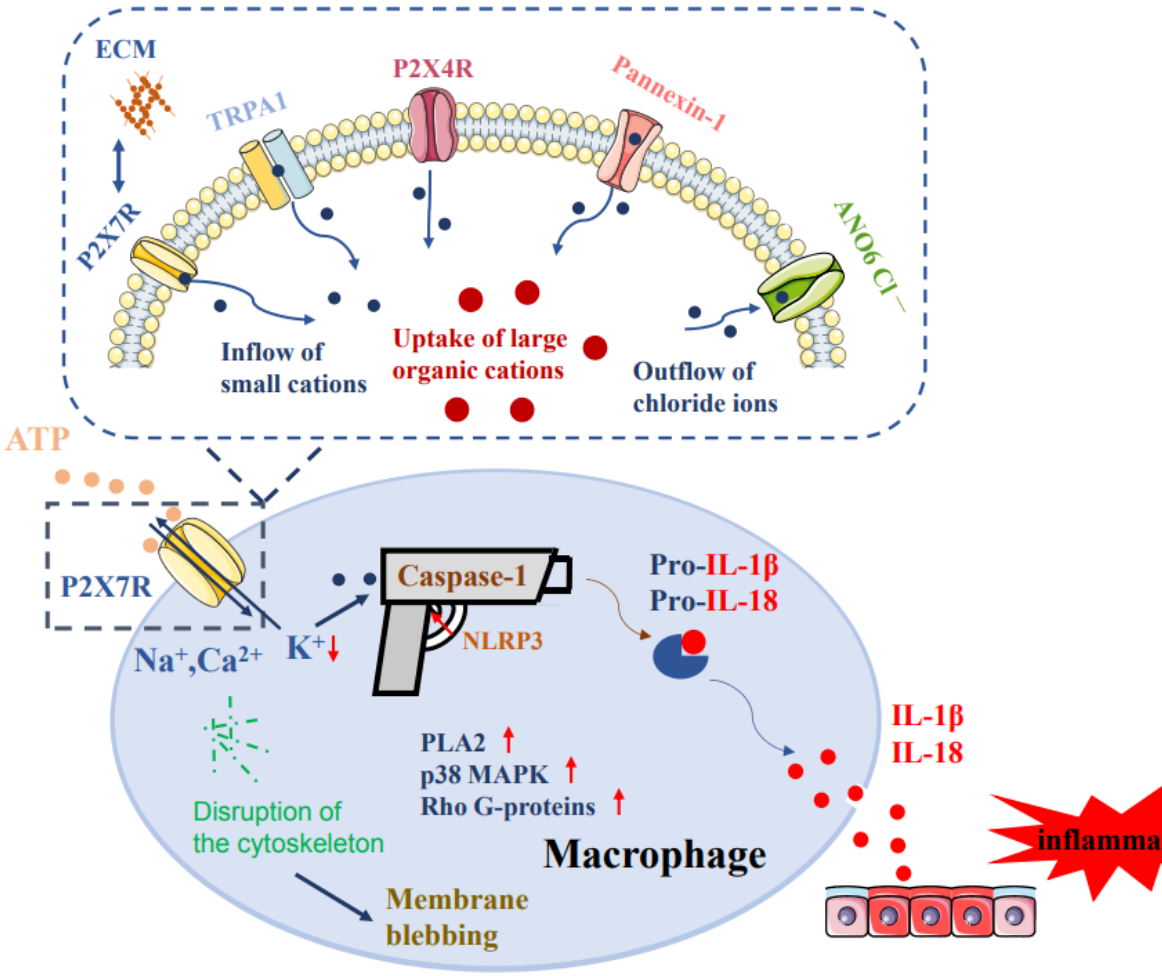
Figure 3. Role of P2X7Rs in macrophages in inducing inflammation. The activation of P2X7Rs by high concentrations of ATP drives the influx of Na + /Ca 2+ and efflux of K + through this plasma membrane-localized receptor channel. A decrease in the intracellular K + concentration is, in co-operation with the stimulation of the toll-like receptor 4 (TLR4) by lipopoly- saccharide, a stimulus for the composition and activation of the nucleotide-binding, leucine-rich repeat, pyrin domain containing 3 (NLRP3). NLRP3 then activates caspase-1, which degrades pro-interleukin-1 β (pro-IL-1 β ) to IL-1 β . IL-1 β is released from macrophages either by membrane diffusion or packed in extracellular vesicles. P2X7R stimulation also leads to the activation of phospholipase A2 (PLA2), p38 mitogen-activated kinase (MAPK), and rho family G-proteins. The pro- inflammatory cytokines IL-1 β and IL-18 cause inflammation. In addition, the stimulation of P2X7Rs initiate the opening of large membrane pores in co-operation with the extracellular matrix (ECM), transient receptor potential A1 (TRPA1) channels, P2X4R-channels, pannexin-1 hemichannels, and anoctamin (ANO6) Cl - channels. These membrane pores allow the uptake of otherwise non-permeable cationic molecules of up to 900 Da, triggering the already-mentioned further ef- fects of the P2X7R. Figuratively spoken, P2X7Rs provide bullets to NLRP3/caspase 1, and NLRP3 triggers the gun to re- lease the pro-inflammatory cytokines (see the central part of the lower